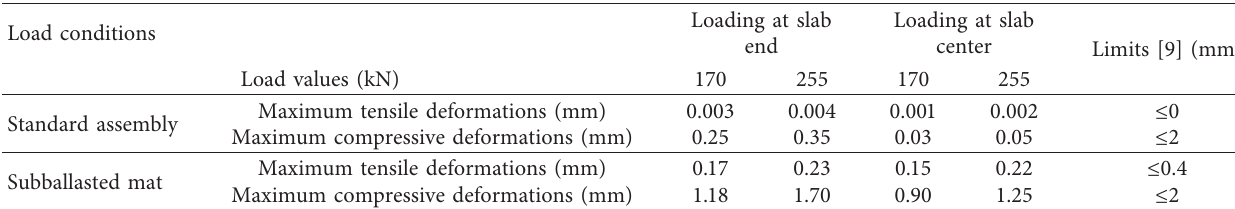
Table 5: The maximum deformations at